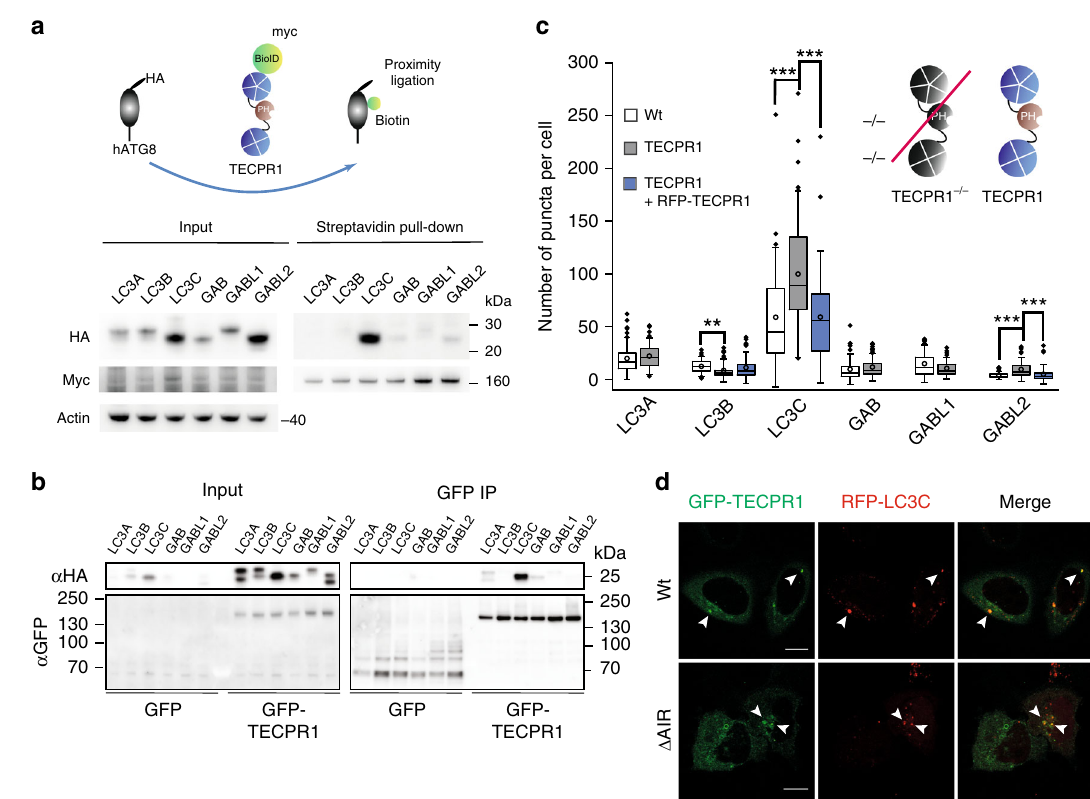
Fig. 1 TECPR1 binds LC3C independently of ATG12 – ATG5. a BioID assay of TECPR1 KO cells cotransfected with MycBioID-TECPR1 and HA-tagged hATG8s. Corresponding cell lysates were precipitated using streptavidin beads and samples were immunoblotted with the indicated antibodies. GAB = GABARAP. b Immunoprecipitation (IP) of GFP-TECPR1 or GFP and co-IP of HA-LC3C from lysates of cells expressing HA-LC3C and GFP-TECPR1 or GFP. Actin served as loading control. Western blots of lysates and co-IPs as indicated. c The number of GFP-hATG8 puncta was counted in starved wild-type (wt) or TECPR1 KO cells as well as in TECPR1 KO cells transfected with RFP-TECPR1 ( n = 47 cells pooled from three independent experiments). Box plots represent the fi rst (25%) and third (75%) quartiles, respectively. The center line represents the median, whiskers the standard deviation and minima and maxima are available from the Source Data fi le. P -values were calculated using a two-tailed Student ’ s t -test (** P < 0.01, *** P < 0.001). d Confocal images of TECPR1 KO cells coexpressing GFP-TECPR1 or GFP-TECPR1 Δ AIR and RFP-LC3C. Both TECPR1 and TECPR1 Δ AIR colocalized with LC3C. Scale bars, 10 µ m. Source data are provided as a Source Data fi